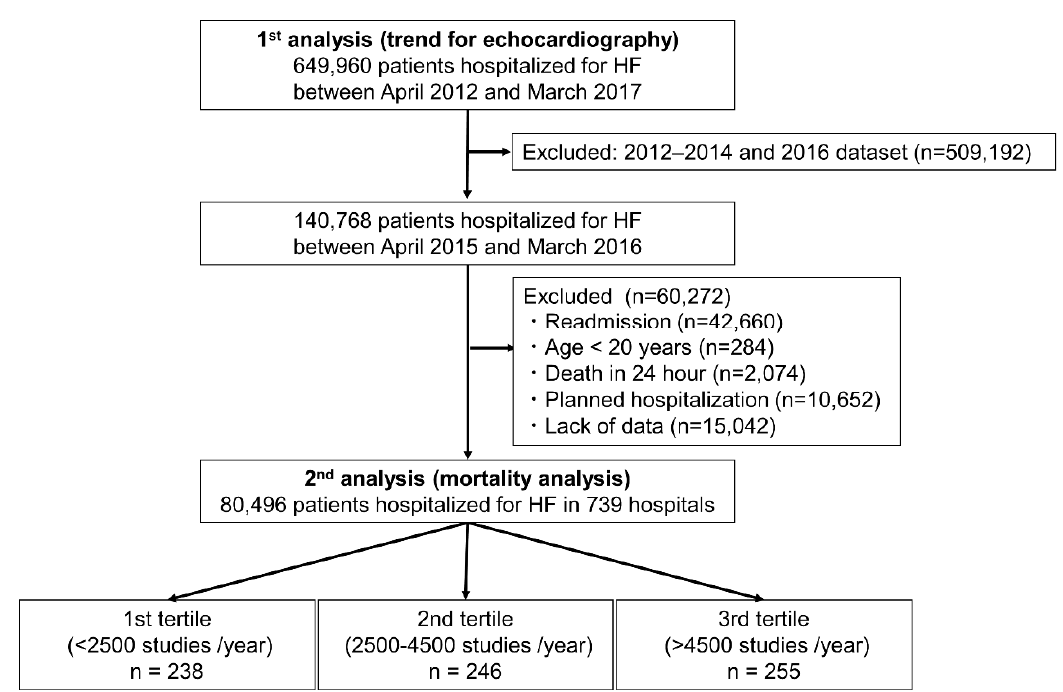
Figure 1. Flowchart of this study. HF, heart failure.